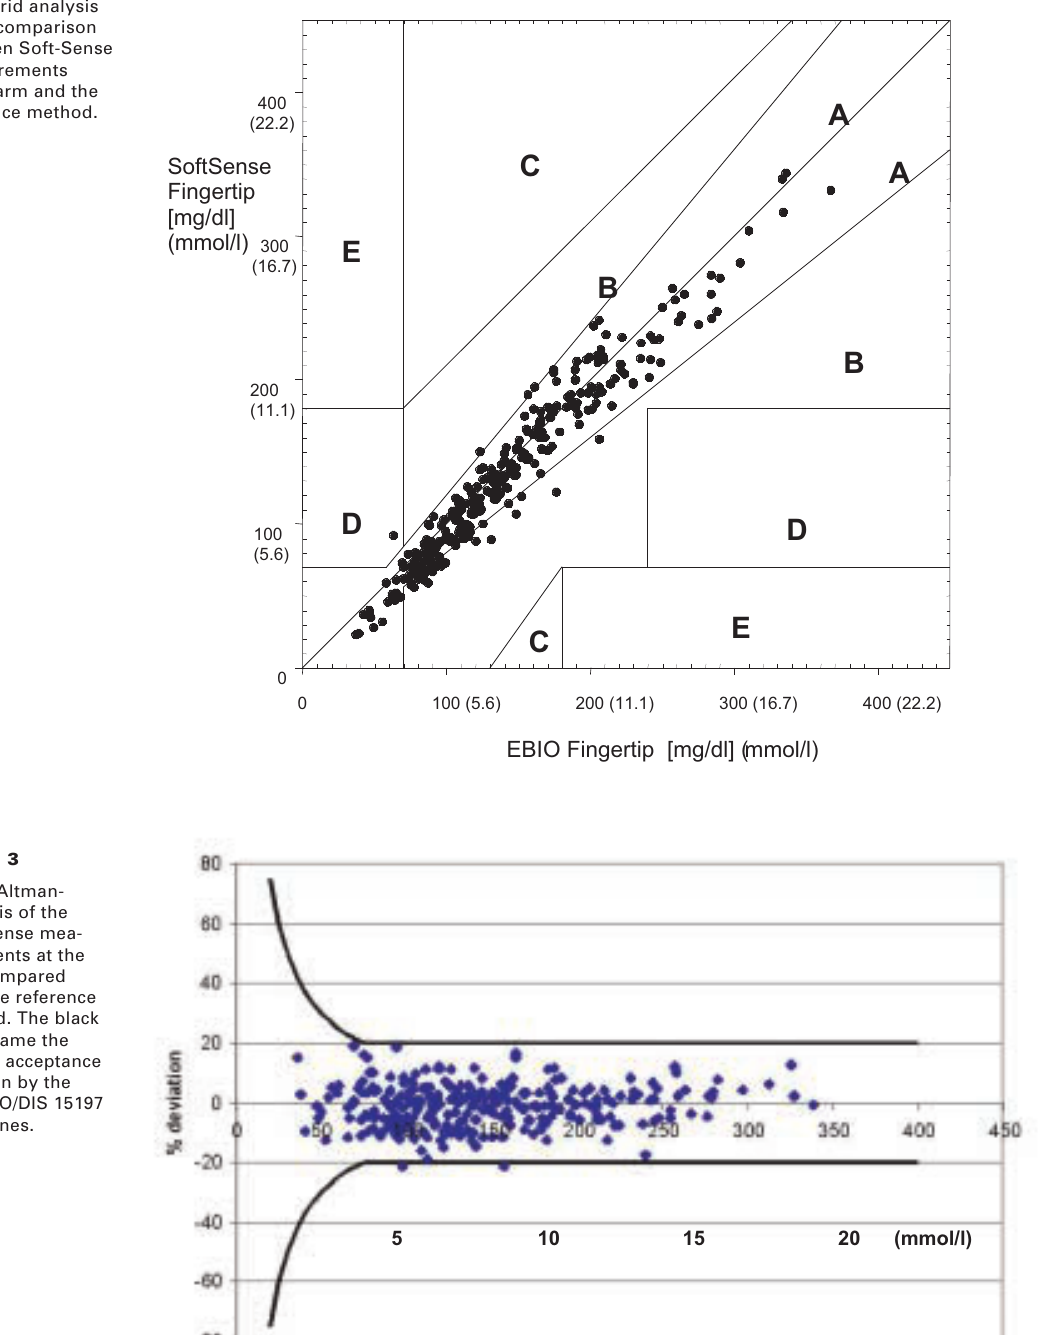
Error grid analysis of the comparison between Soft-Sense measurements at the arm and the reference